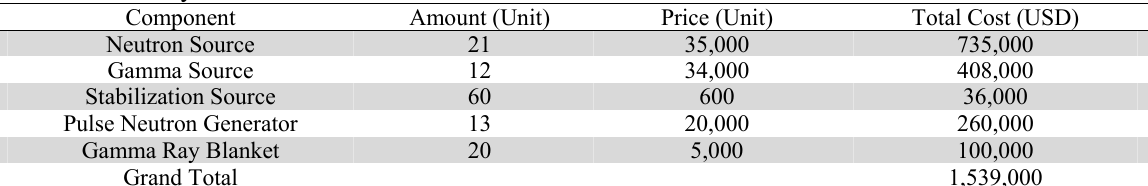
Annual Inventory Cost